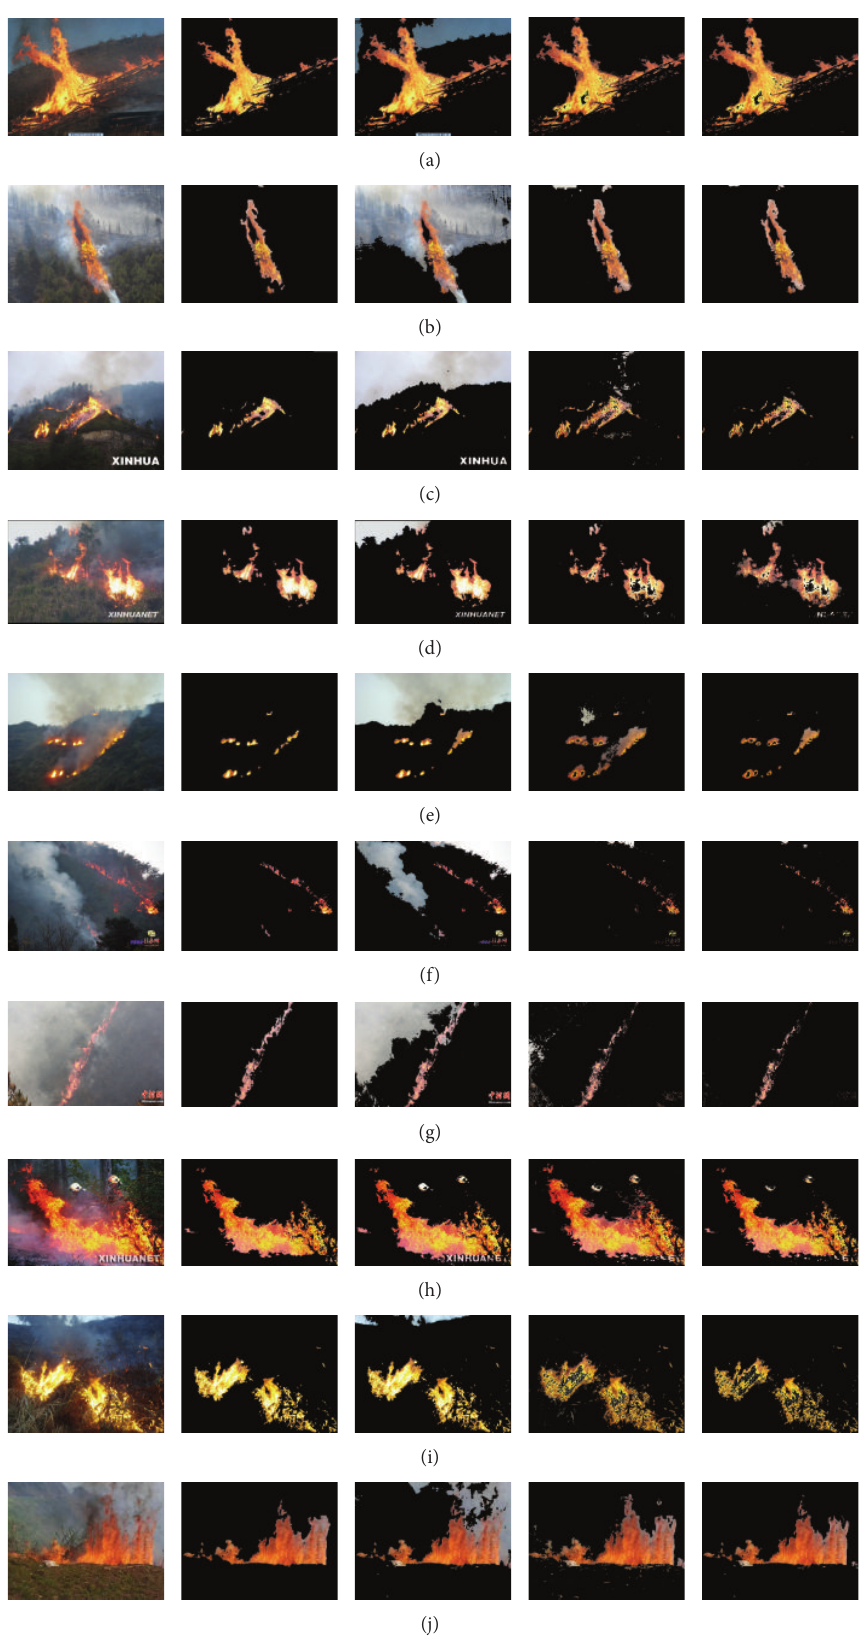
Figure 8: Experimental results of wildfire segmentation from